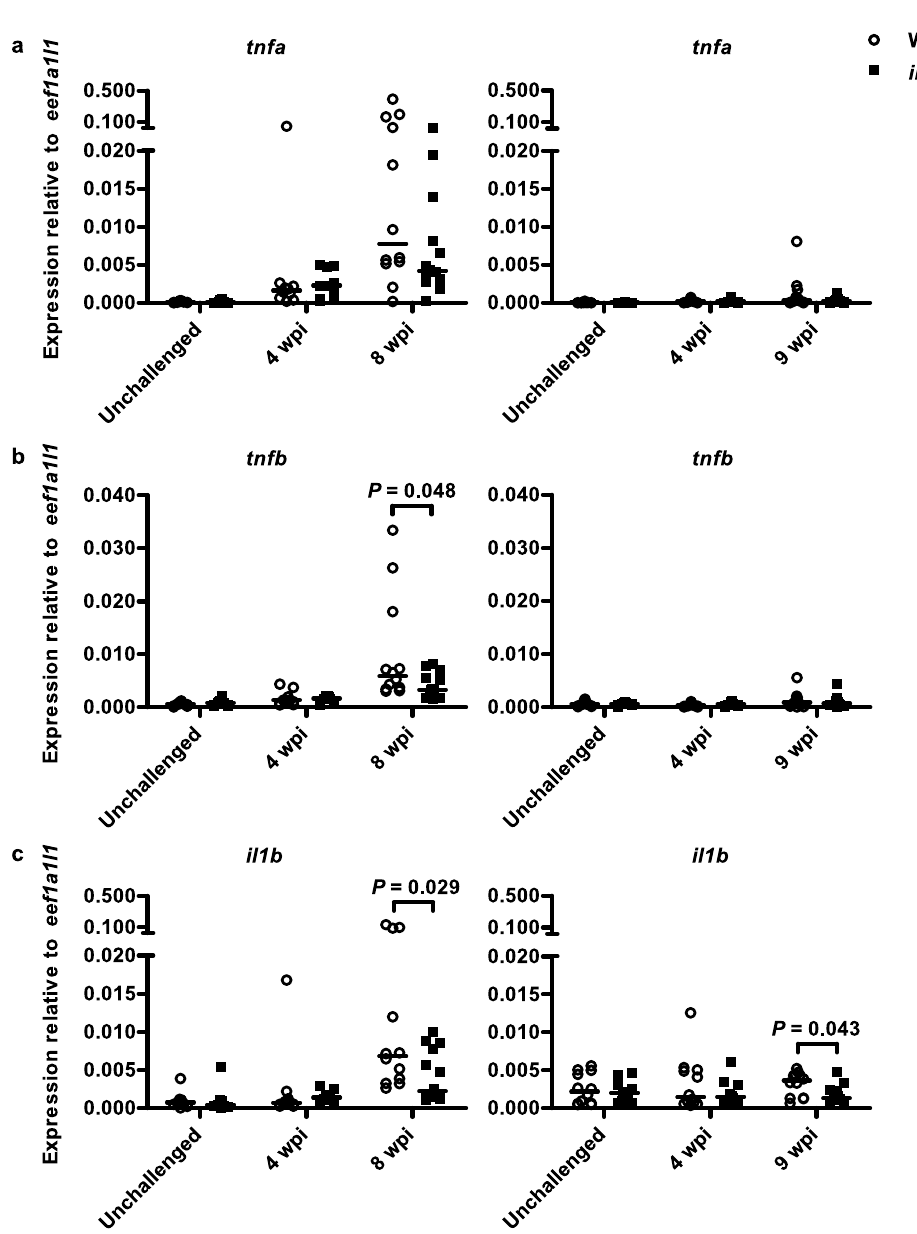
Figure 8. il10 e46/e46 mutant zebrafish have reduced inflammation in a chronic mycobacterial infection. ( a – c ) The relative expression of selected proinflammatory cytokines ( il1b , tnfa , tnfb ) in kidneys of unchallenged il10 e46/e46 mutants ( n = 10) and WT control fish ( n = 10) and in the unsorted kidney cell populations of il10 e46/e46 mutants ( n = 10–14) and WT control fish ( n = 10–12) at 4 and 8 weeks post a low-dose (1–18 CFU) infection (on the left) as well as in the abdominal organ blocks (including kidney) of unchallenged il10 e46/e46 mutants ( n = 12) and WT control fish ( n = 12) and at 4 and 9 weeks post a low-dose (2–9 CFU) infection ( n = 12 and n = 12, respectively) (on the right) were measured with qPCR. Data are presented as a scatter dot plot and median. Note the different scales of the y axes and the divided y axis in panel a. Gene expressions were normalized to the expression of eef1a1l1 . Each dataset was collected from a single experiment. A two-tailed Mann-Whitney was used for the statistical comparison of